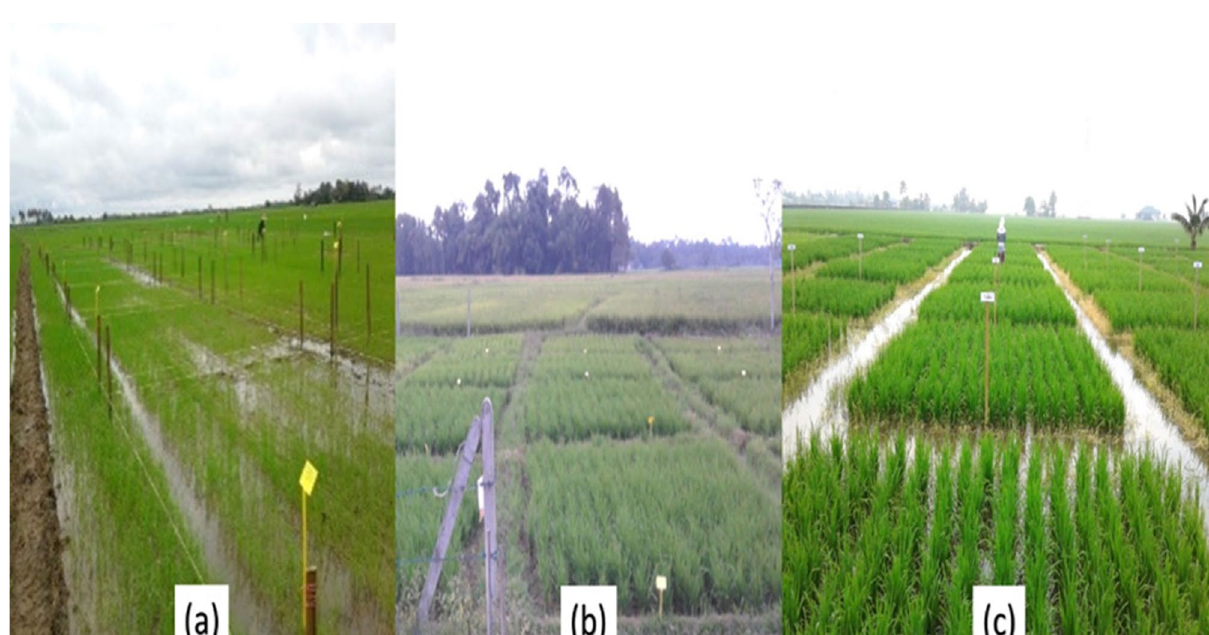
Figure 2. Experimental plots at ( a ) MADA, ( b ) KADA and ( c ) IADA BLS